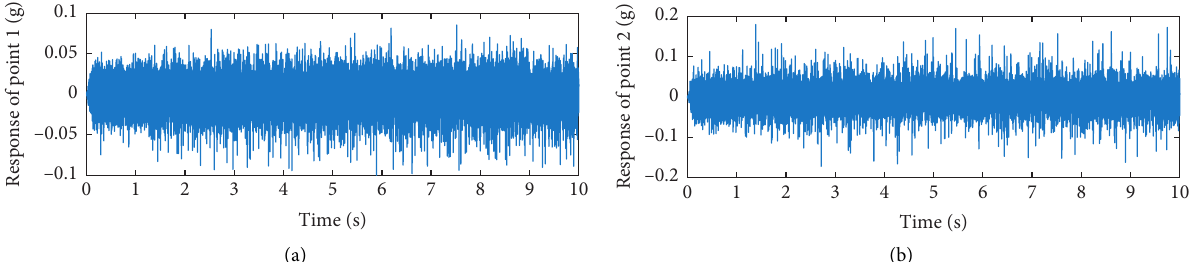
Figure 24: Response signals of the two points on the vibration table.